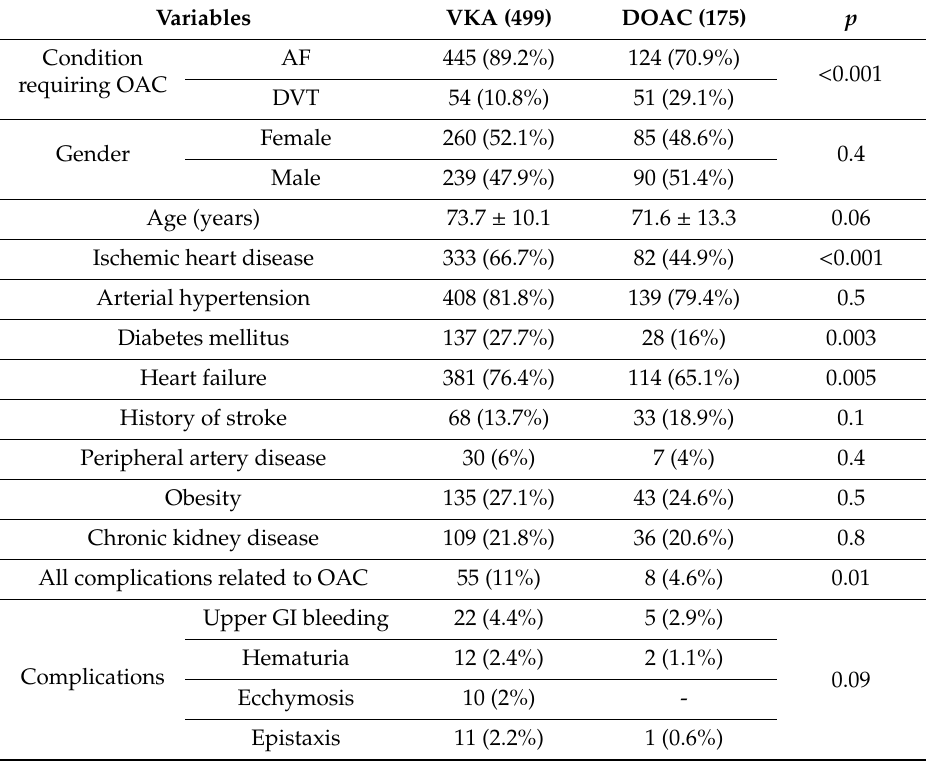
Table 2. Comparison between VKA and DOAC group.